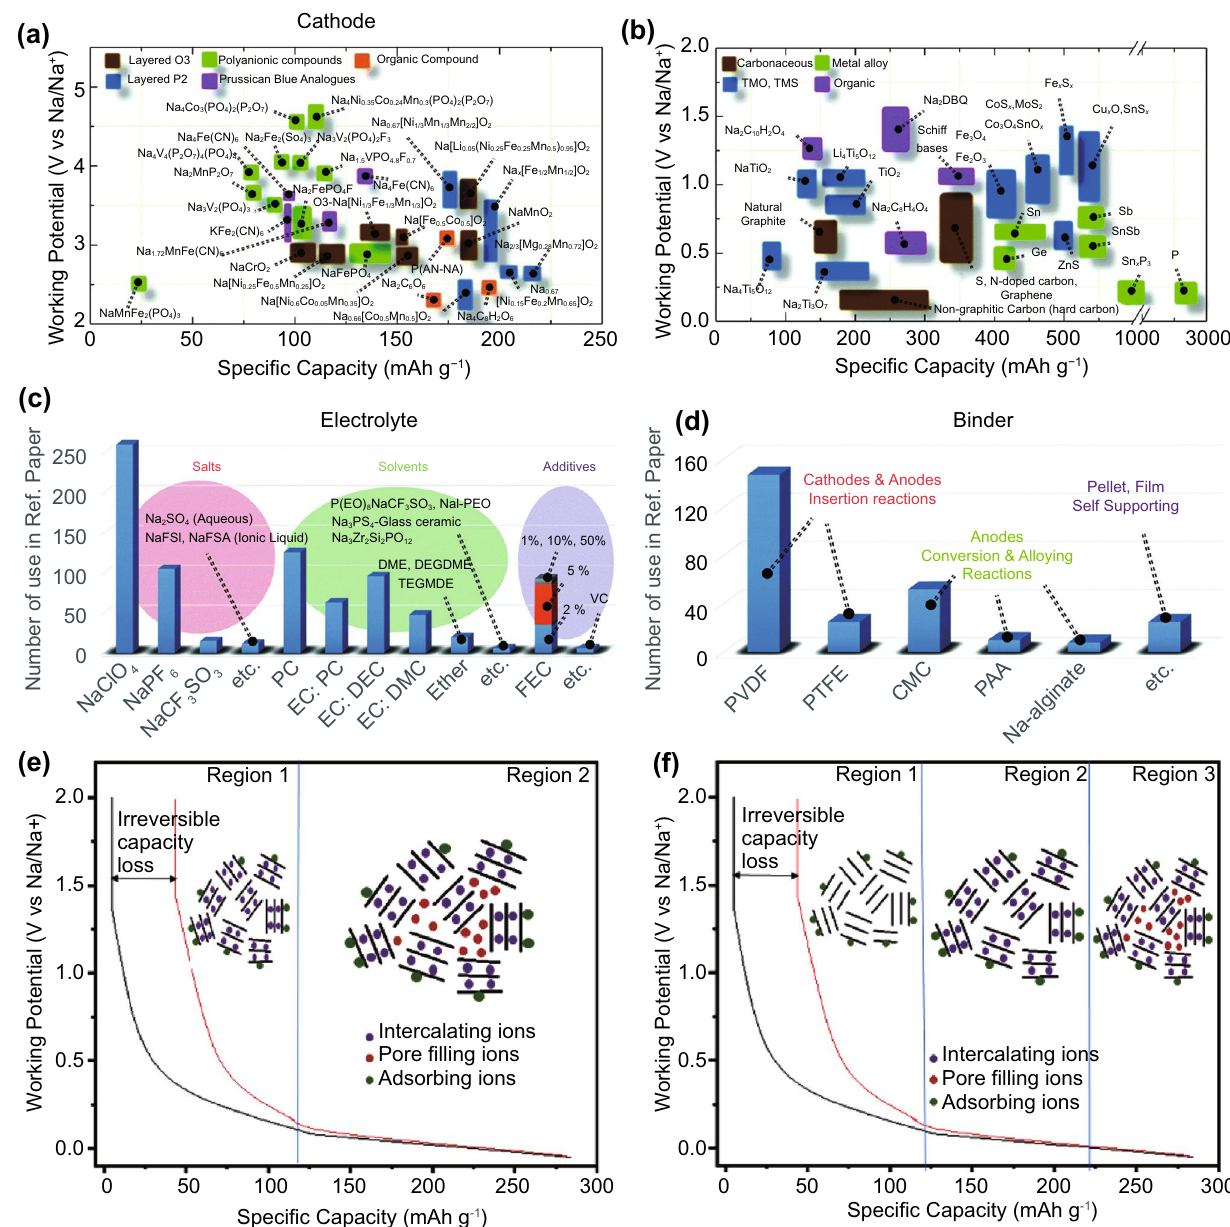
Fig. 6 A non-exhaustive visual summary of selected a cathodes, b anodes, c electrolytes and d binders that have been explored for sodium-ion batteries [9] . Creative Commons License (CC BY 3.0). e Initial model for sodium ion insertion into hard carbon, attributing the sloping region to intercalation and low potential plateau to pore-filling. f A more recent model for sodium insertion into hard carbon, attributing the sloping region with defect binding, and the low potential plateau to intercalation and pore-filling [50] . Copyright 2020,